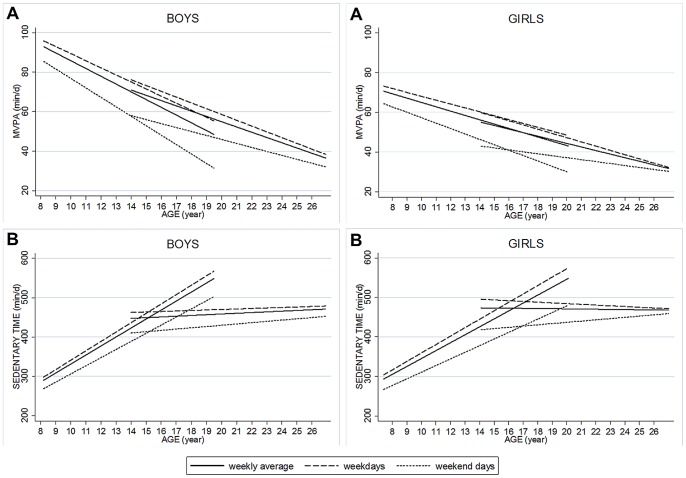
Changes in weekly, weekday and weekend moderate-to-vigorous physical activity (Panel A, MVPA, min/d) and sedentary time (Panel B, min/d).Slopes result from mixed effect models adjusted for age, country, registered time and number of valid days (N = 821 and 989, for boys and girls respectively).